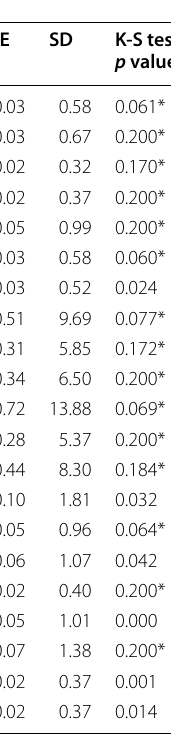
Table 5 Descriptive statistics for age and stature of subjects selected